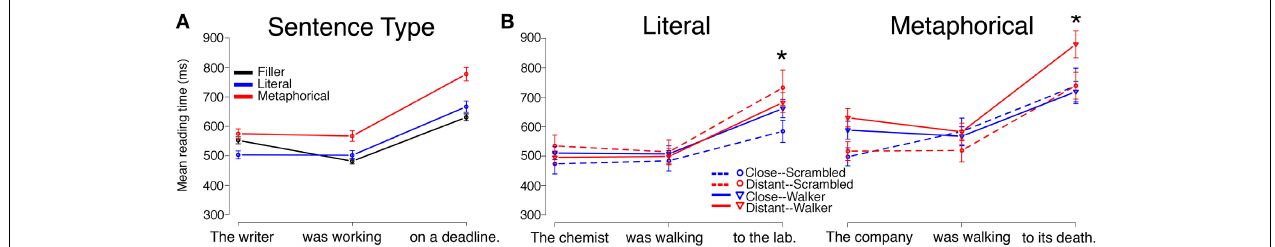
FIGURE 4 | Reading times for sentence regions from the Static Group in Experiment 2 are displayed by (A) Sentence Type and (B) by Verb Match and Prime Type for Literal and Metaphorical sentences. Error bars represent standard errors of the mean. No significant main effects or interactions between Verb Match and Prime Type were observed at the